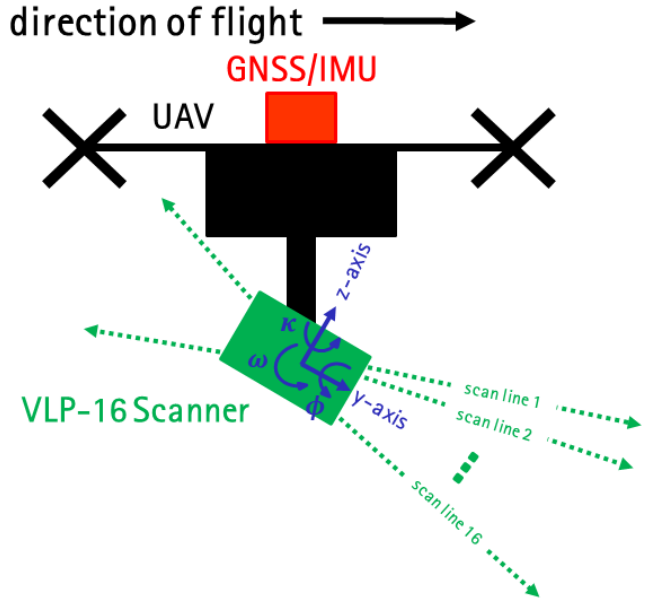
Figure 6. Modified sketch of the UAV platform setup from [1]. The x -axis of scanner’s local coordinate system is in the reader’s line of sight.